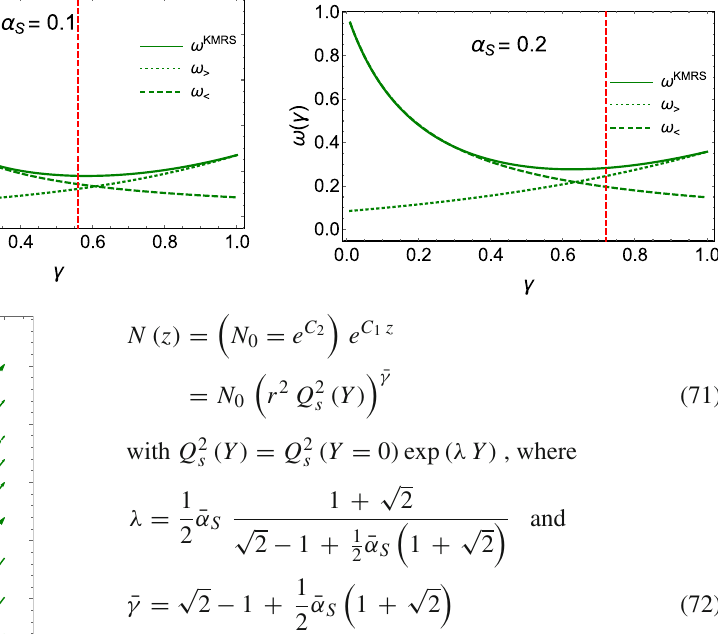
Fig. 3 The eigenvalues ω versus γ . The vertical dashed lines show the value of ¯ γ = 1 − γ cr for different values of ¯ α S . ω > ≡ ω m is given by Eq. (55). ω < is the same as in